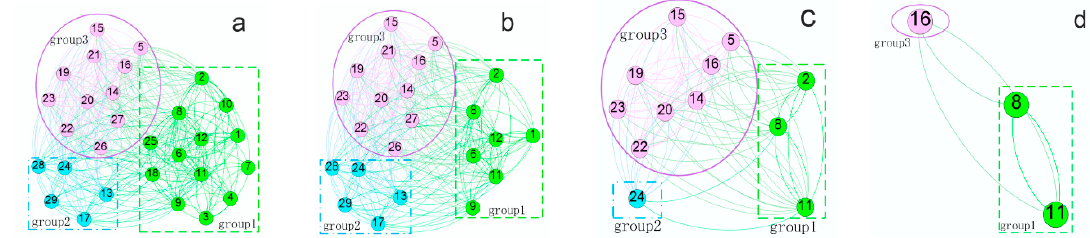
Figure19. Topologyviewsoflayer1atdi ff erentrangesofdegree: ( a ) Degree ∈ [ 8,42 ] , ( b ) Degree ∈ [ 18,42 ] , Figure 19. Topology views of layer1 at different ranges of degree: ( a ) ( c ) Degree ∈ [ 28,42 ] , ( d ) Degree ∈ [ 35,42 ] .